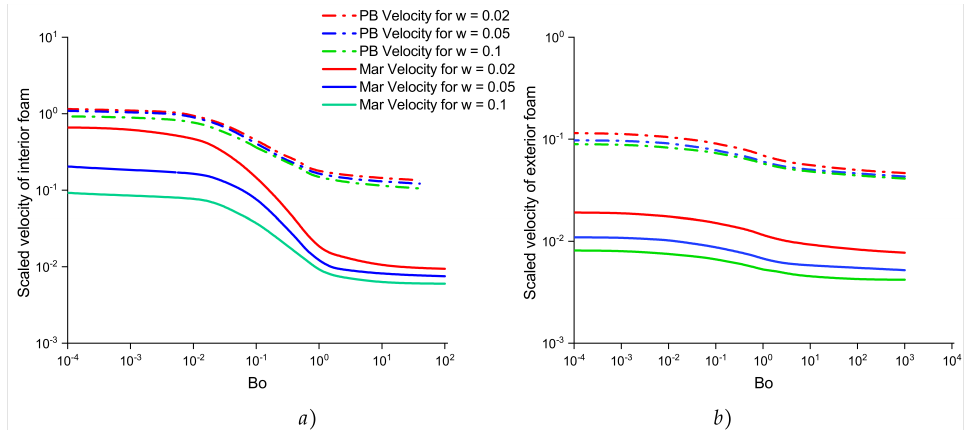
Figure 8. PB and Marangoni velocity in different film thickness are simulated in different Bo number for ( a ) interior films and ( b ) exterior films.